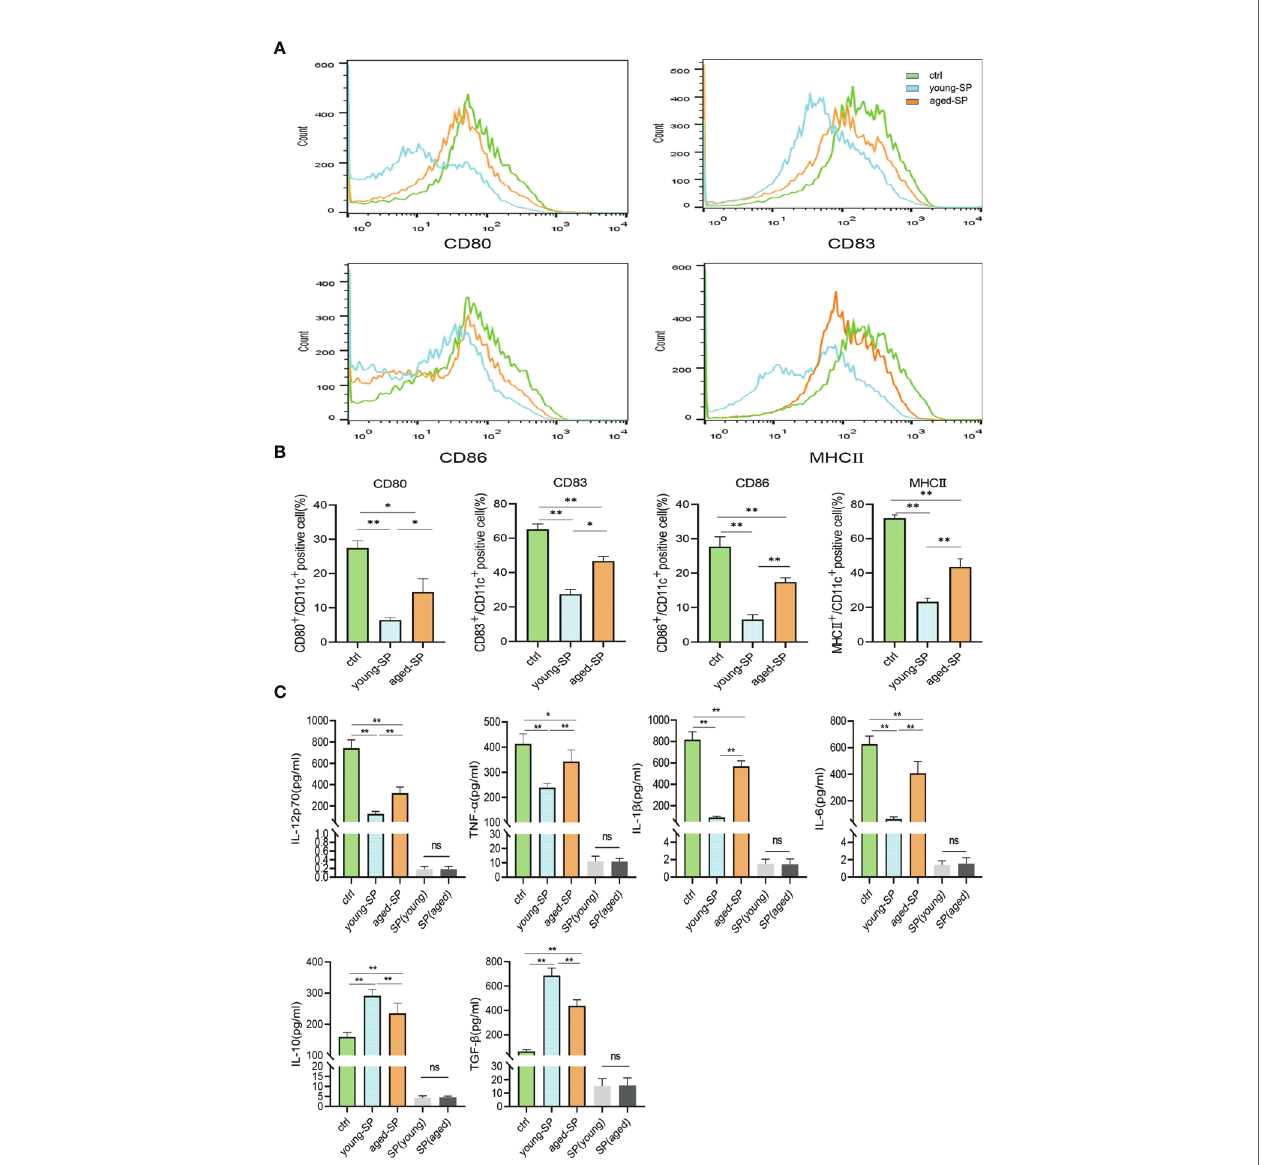
FIGURE 4 | Alterations of BMDC maturation status between young-SP group and aged-SP group in vitro . (A) Fluorescence-activated cell sorting (FACS) analysis of CD80, CD83, CD86, and MHCII in culture supernatant. The x-axis represents the fl uorescence intensity, and the y-axis represents the percentage of positive cells. (B) Quanti fi cation of CD11c+ CD80+ DC, CD11c+ CD83+ DC, CD11c+ CD86+ DC, CD11c+ MHCII+ DC positive cells as seen in panel A (mean ± SD, n = 6). (C) ELISA analysis demonstrating the concentration of IL-12p70, TNF- a , IL-1 b , IL-10, TGF- b , and IL-6 in the culture supernatant (mean ± SD, n = 6). The differences among different groups were assessed by one-way ANOVA with Holm – Sidak post-hoc test. *p < 0.05 and **p < 0.01. BMDC, marrow-derived dendritic cell; SP, seminal plasma; DC, dendritic cell; ns, not signi fi